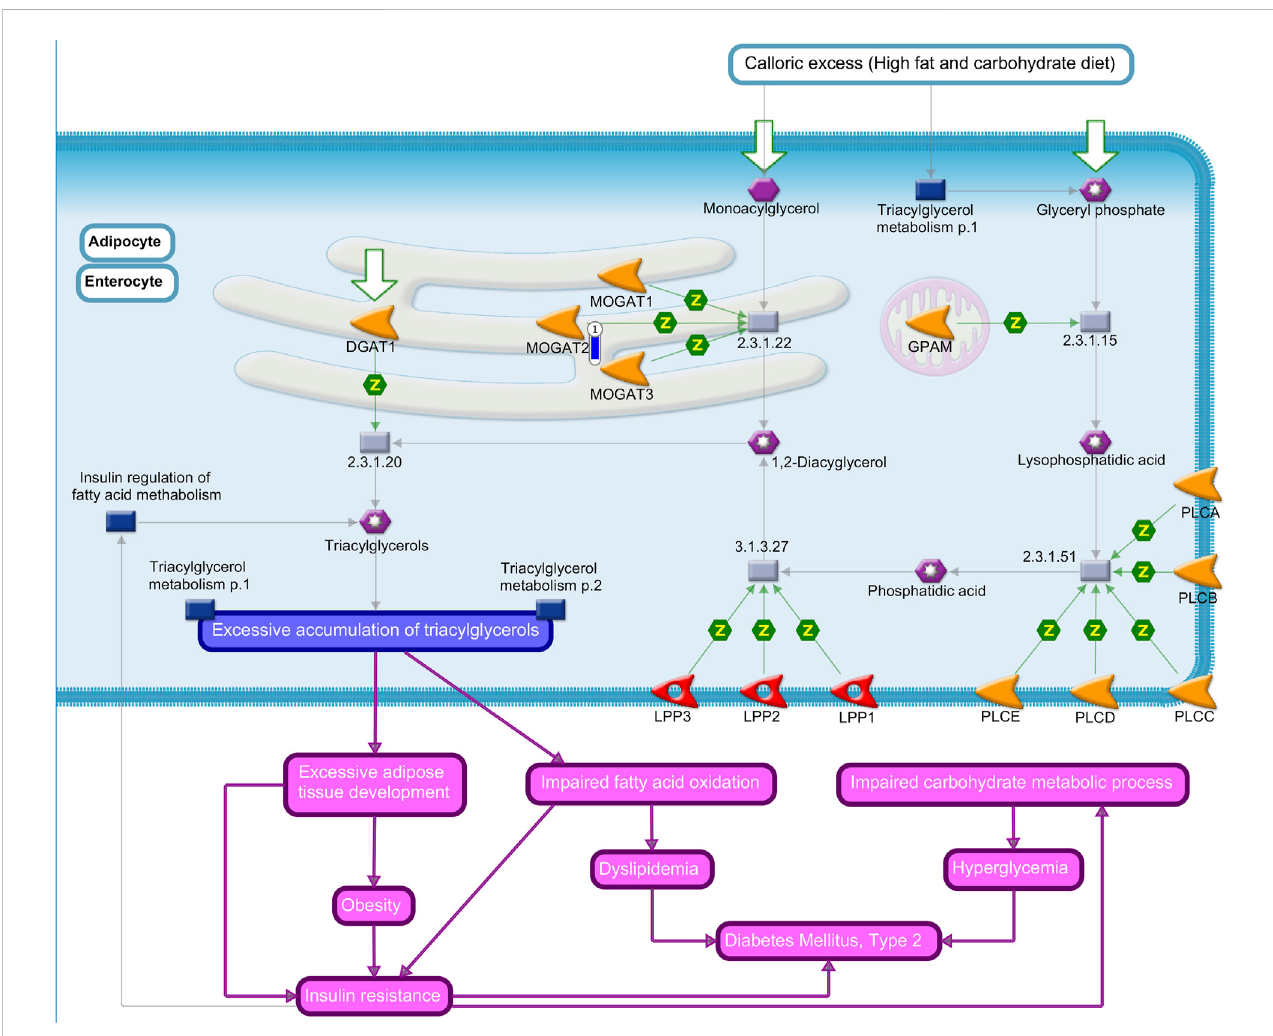
FIGURE 3 Triacylglycerol biosynthesis in obesity and the diabetes mellitus type II pathway map by MetaCore software ( p -value < 0.10) from the list of differentially expressed genes (FDR 10%) in the liver tissue of pigs fed with different oils in the diet (3.0% canola oil and 3.0% soybean oil). The blue thermometer indicates that theDEGisdownregulated(log2-foldchange − 4.72)inthedietwith 3.0%ofCO.Purple lines indicateincreasesindiseases. Green arrowsindicatepositive interactions, and gray arrows indicate unspeci fi ed